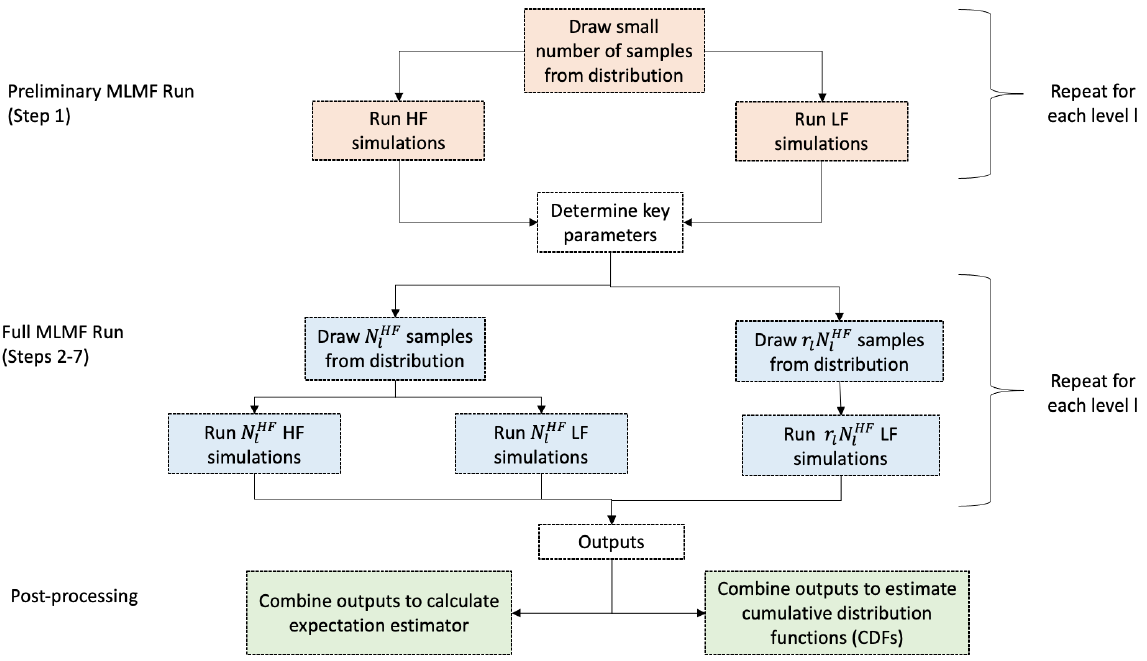
Figure 2. Flowchart of the multimodel approach to MLMF using HF (XBeach) and LF (SFINCS).